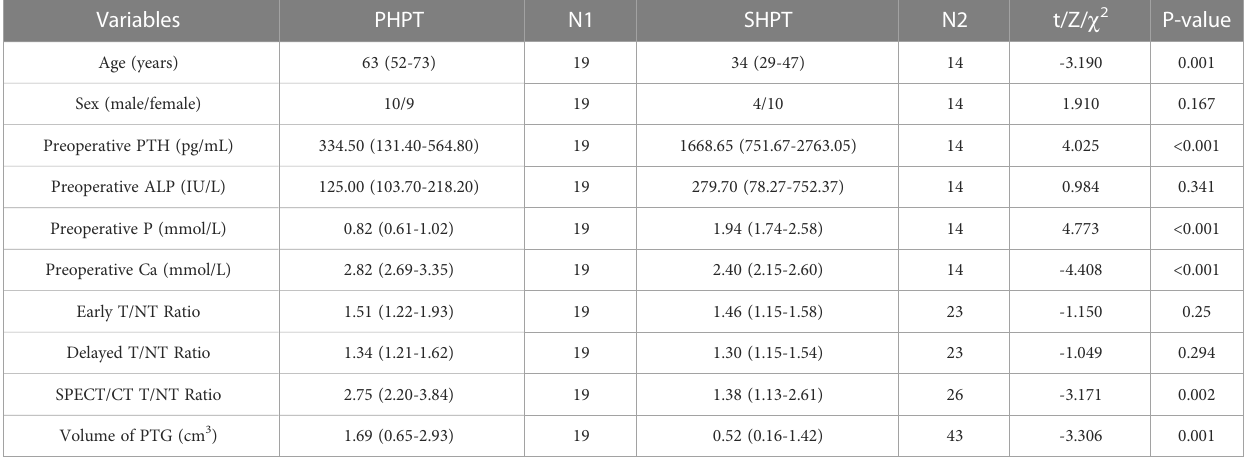
TABLE 1 Baseline characteristics of patients included in the study.